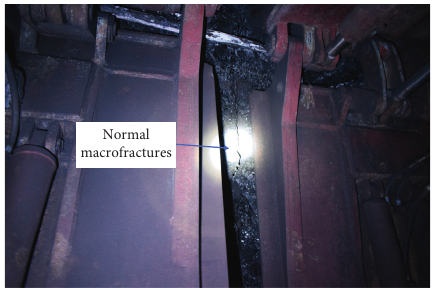
Figure 6: Normal macrofractures in the working